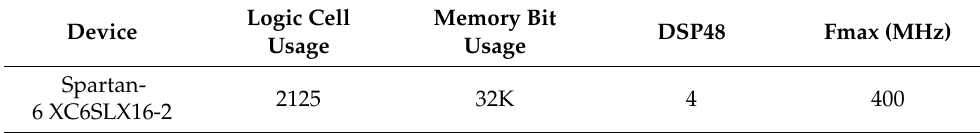
Table 1. Resource and performance of